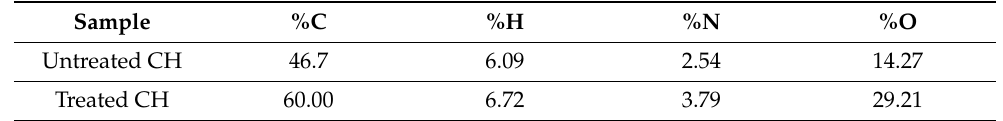
Figure 7. Representative chromatogram of pantoprazole achieved after extraction by a developed adsorbent ( A ) and a commercially available silica-based C18 column ( B ). Table 2. Elemental analysis of untreated and treated